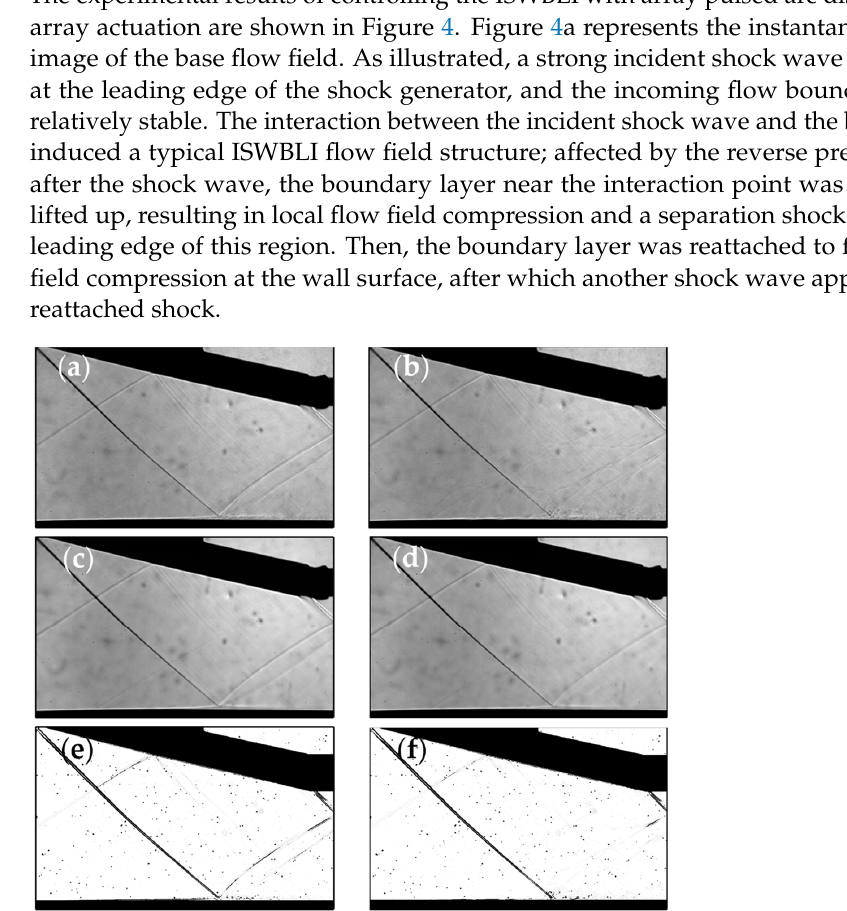
Figure 4. Experimental schlieren results: ( a , c , e ) the base flow field; ( b , d , f ) the actuation flow